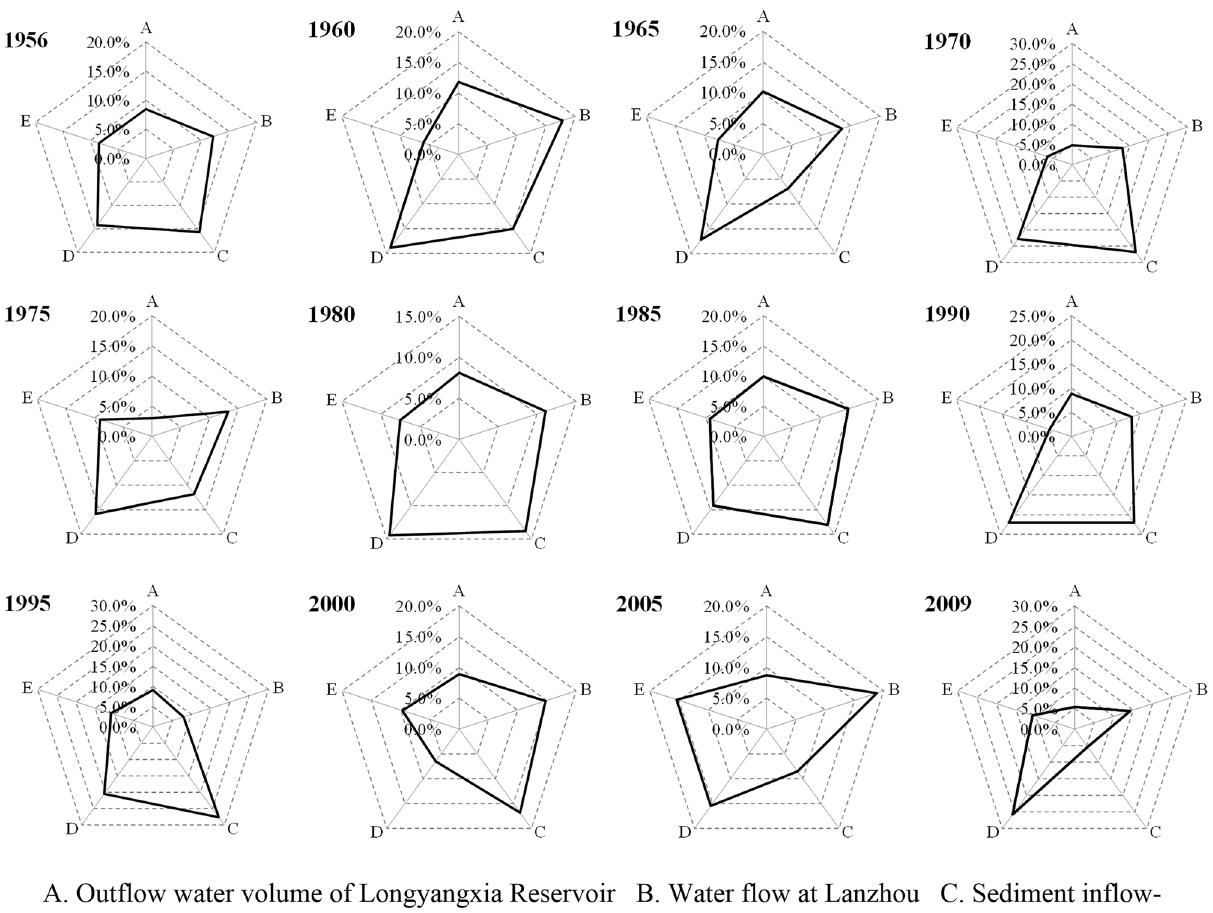
Figure 5. Entropy weight analysis of the key indices of the internal water–sediment–electricity system at the interannual scale in the current